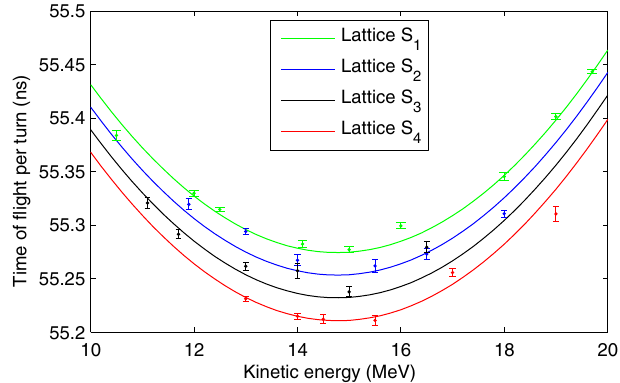
FIG. 18. Experimental measurements of the time of flight (TOF) per turn are compared with simulation results for four different lattice configurations. A model is initially fitted to TOF measurements in a single lattice configuration at four different energies; then the models for new configurations are constructed by applying the same changes to the fitted model, as are applied in the